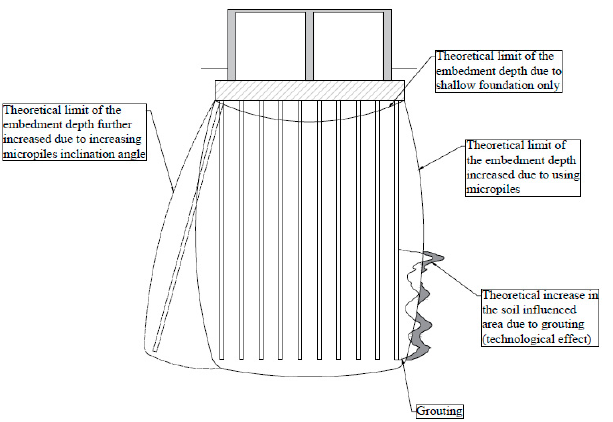
Figure 7. MPs possible influence on the kinematic interaction due to the embedment depth (after [17,19,20]). Complex SSI (soil–structure interaction) analysis might be a good option to manage seismic wave propagation issues, similar, for example, to the recent work of Con ț iu et al. [21], which compared the structural response of a bridge pier using analyses with different levels of SSI complexity. The authors also compared the deterministic approach and simple design methods with a probabilistic approach. The latter allows for more accuracy in modeling the soil dynamic properties, which can also be very helpful in studying the seismic behavior of MP and MPed structures, as a probabilistic approach can capture more accurately and in detail the local behavior of the soil that is influencing wave propagation. Referring to seismic waves, they are divided into two types, body and surface waves; in many cases the focus is on body waves, as in most of the discussed papers. Even so, the foundation is excited by both types and not considering these two types of seismic waves in the studies may limit the ability of reaching rigorous conclusions. Two possibilities exist: body waves arrive before surface waves or intersecting of body and surface waves. From the point of view of the authors, the role of MPs can be useful in decreasing the